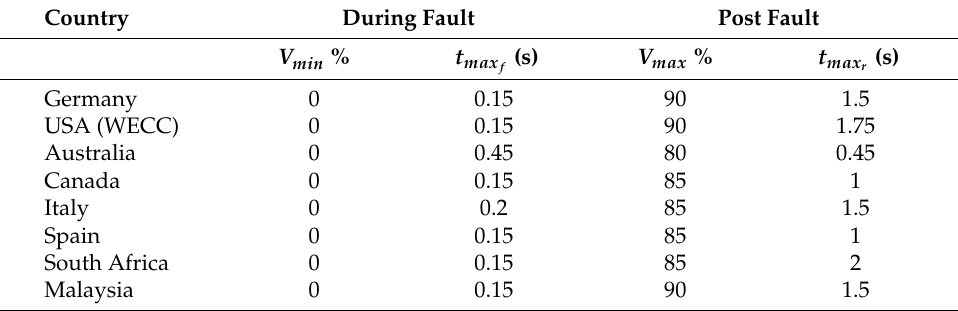
Table 3. Parameters of the ZVRT in various